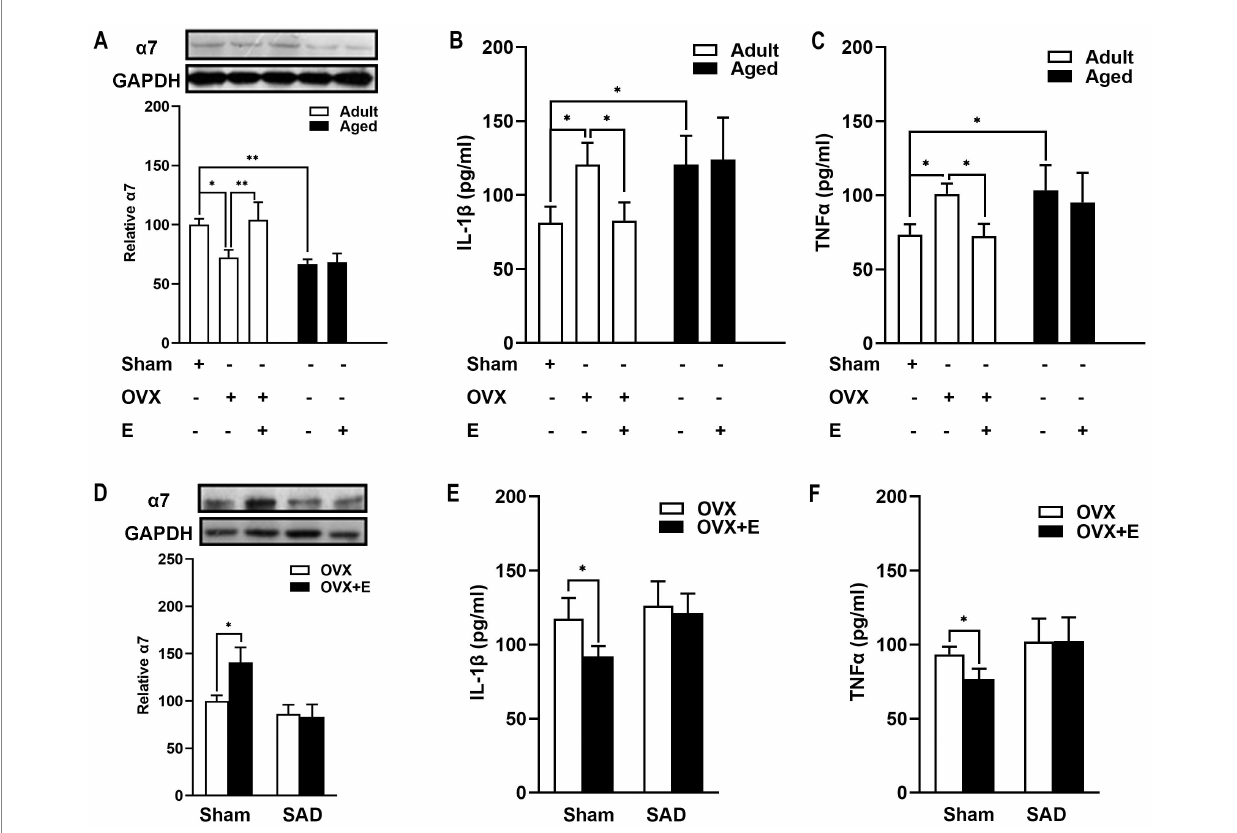
FIGURE 6 Estrogen decreased the expression of brain α 7nAChR and the level of proinflammatory cytokines in an arterial baroreflex-dependent manner in adult OVX rats? (A) In adult rats, OVX led to a reduced expression of α 7nAChR, whereas estrogen treatment reversed such a reduction. α 7nAChR expression was weaker in aged rats than in adult rats and was not affected by estrogen supplements. (B,C) In adult rats, estrogen supplements alleviated the increase in serum TNF- α and IL-1 β following MCAO in OVX rats. Whereas in aged rats, MCAO-induced inflammation was more serious than in adult rats, and estrogen treatment did not reduce the release of serum TNF- α and IL-1 β . (D) SAD decreased the expression of α 7nAChR in an OVX rat brain. Arterial baroreflex impairment by the SAD abolished the effect of the estrogen-enhancing α 7nAChR. (E,F) SAD attenuated the reduction of proinflammatory cytokines induced by the administration of estrogen. Data were analyzed by one-way analysis of variance (ANOVA) followed by least significant difference t -test, n = 3–6 in each group. * p < 0.05, ** p <